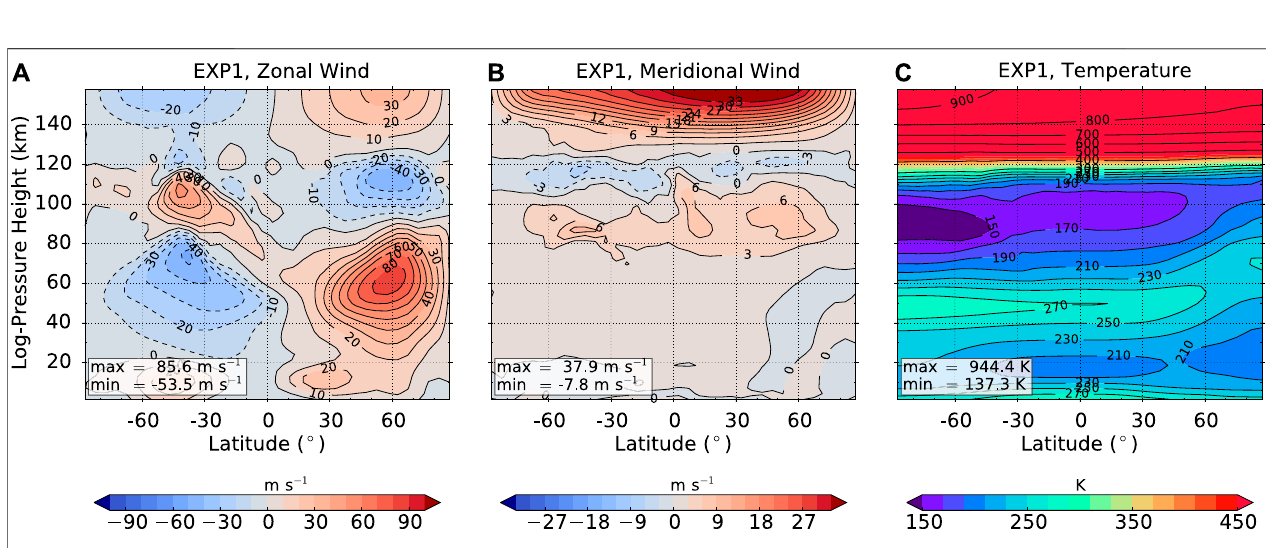
FIGURE 2 | Zonal mean zonal wind (A) , meridional wind (B) , and temperature (C) for EXP1 simulation. Units in (A,B) m s − 1 and (C) K. Contour lines show intervals of (A) 10 m s − 1 , (B) 3 m s − 1 , and (C) 20 K (for T < 300 K) and 100 K (for T ≥ 300 K), respectively.